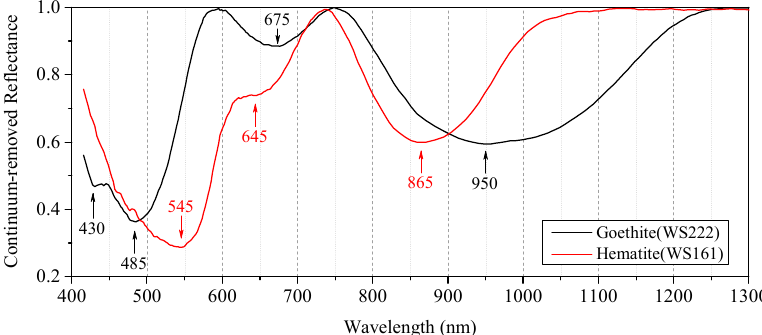
Figure 8. Continuum-removed spectra of hematite and goethite (the United States Geological Survey (USGS) mineral spectral library). Absorption features around 430, 485, 675, and 950 nm by Goethite and Absorption features around 545, 645, and 865 nm by Hematite.